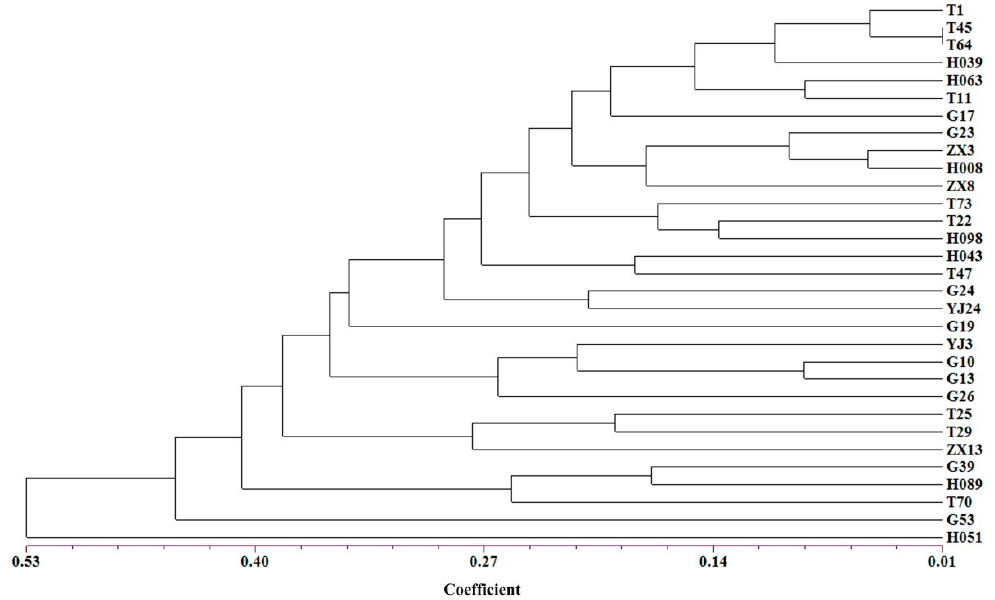
Figure 5. The Unweighted Pair Group Method with Arithmetic Mean (UPGMA) tree of the core collection based on Nei’s unbiased genetic distance.